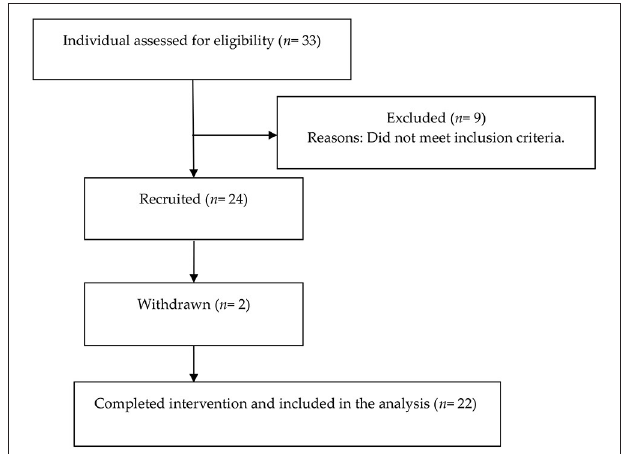
FIGURE 1 | Flow chart diagram of the study